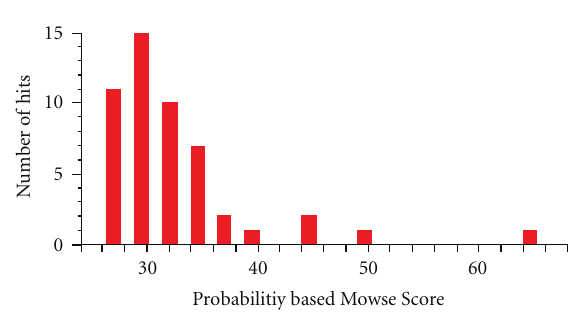
Figure 11: Mascot search results of protein spot 5 are TNFRS8. Mowse Score is 110 ( > 58, P < .